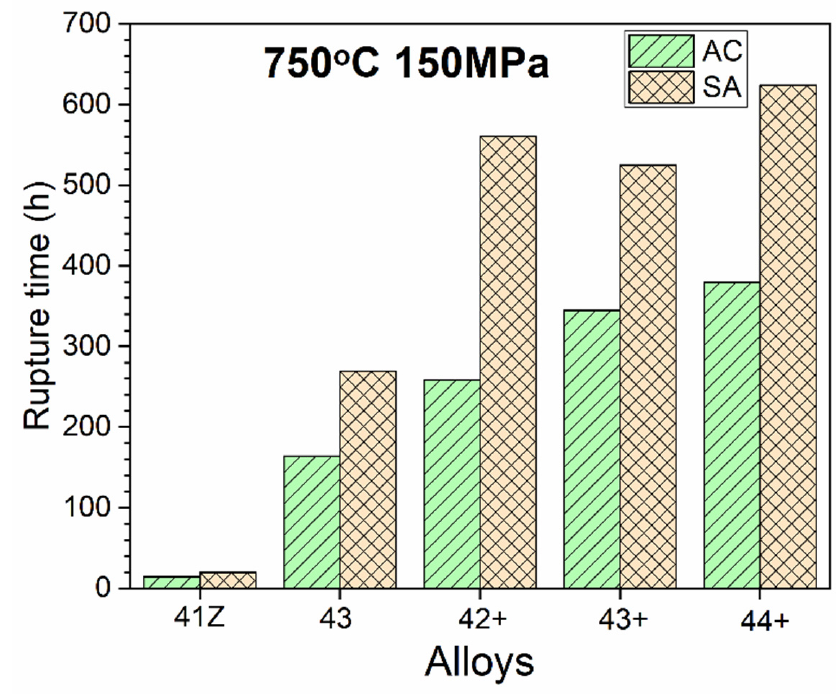
Figure 7. Creep rupture life of the alloys in air at 750 °C and 150 MPa.